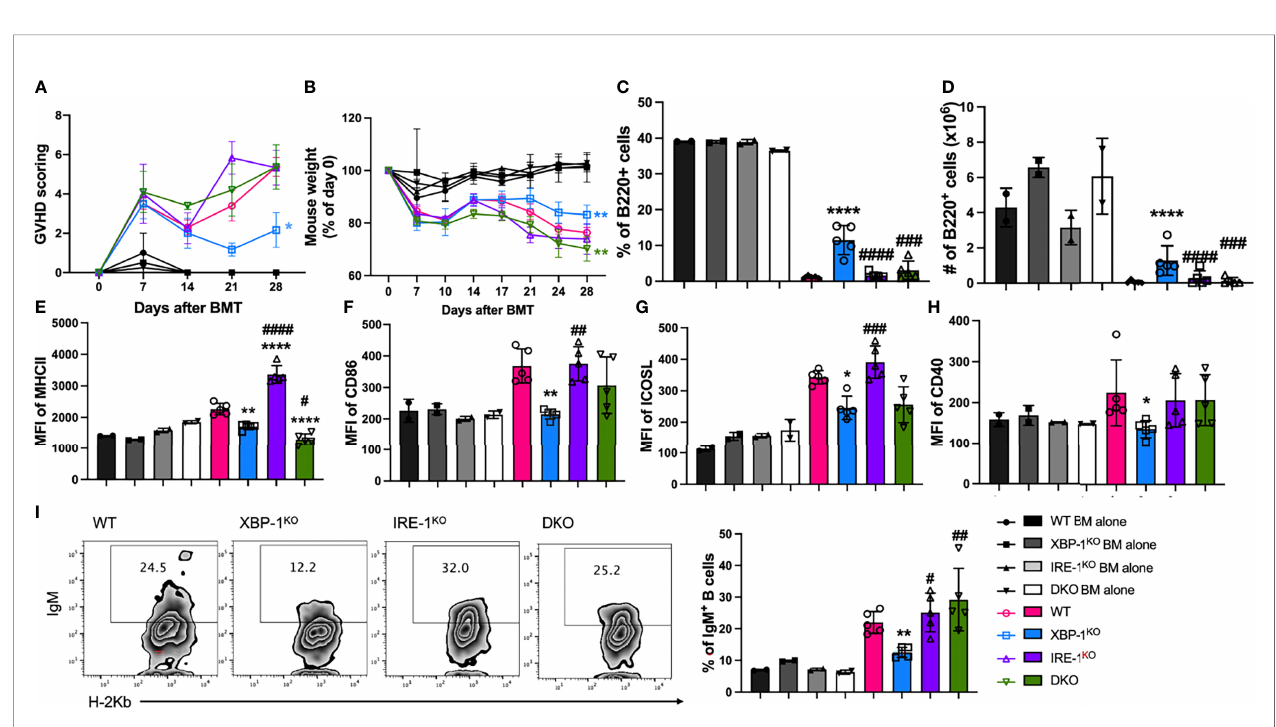
FIGURE 4 | Effect of XBP-1s and IRE-1 a on B cell activation and cGVHD pathogenicity. BALB/c mice were lethally irradiated and transplanted with 5 x 10 6 TCD- BM cells from WT, XBP-1 KO , IRE-1 a KO , and DKO mice on a B6 background with (n = 20) or without (n = 8) 0.35 - 0.5 x 10 6 splenocytes. GVHD scoring (A) and mouse weight (B) were monitored during the experiment. Subsets of recipient mice were euthanized on day 28, and spleens were dissected and processed into single-cell suspension. The percentages of B220 + B cells (C) and the expression levels of MHCII (D) , CD86 (E) , ICOSL (F) , and CD40 (G) were detected by fl ow cytometry analysis. Intracellular expression of IgM (H, I) was also determined using fl ow cytometry. Data show the representative result from three independently repeated experiments. 28 recipient mice were used for each experiment. Statistics were performed using two-way ANOVA with Tukey ’ s multiple comparison test for (A, B) One-way ANOVA with Tukey ’ s multiple comparison test was used for others. *p < 0.05, **p < 0.005, and ****p < 0.0001 when compared to WT. # p < 0.05, ## p < 0.005, ### p < 0.0005, and #### p < 0.0001 when compared to XBP-1 KO group.